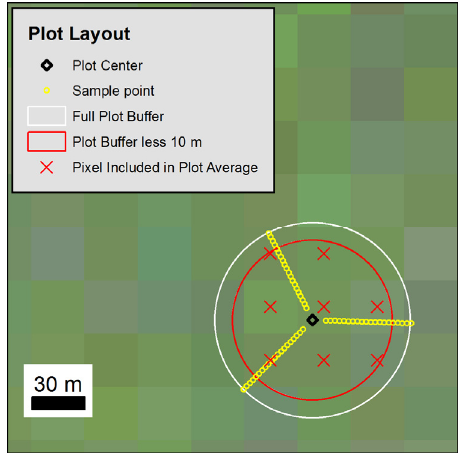
Figure 3. Layout of point-intercept field plot, North Slope, Alaska. Lines sampled by ABR were 50 m in length; lines sampled by BLM were 25 m. Pixels from a midsummer Landsat composite (red/green/blue) are in the background. The pixels with centers inside a circular plot buffer less than 10 m were included in the calculation of average predictor values for each plot.